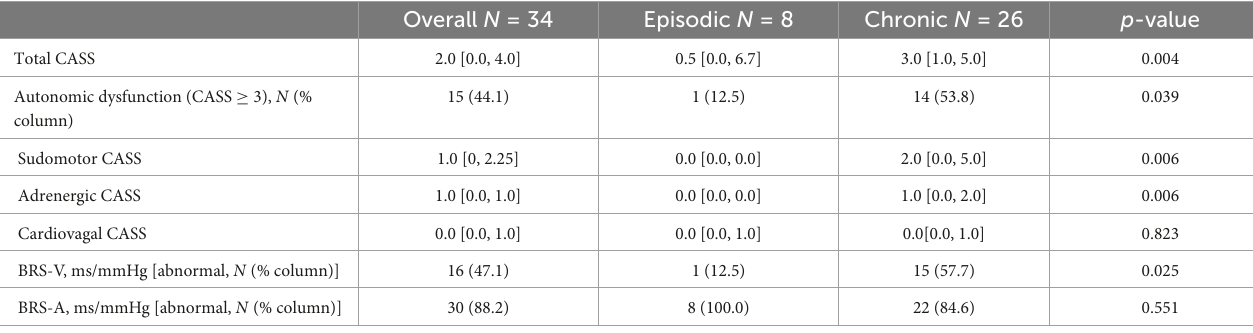
TABLE 2 Associations between autonomic reflexes, headache chronicity*.